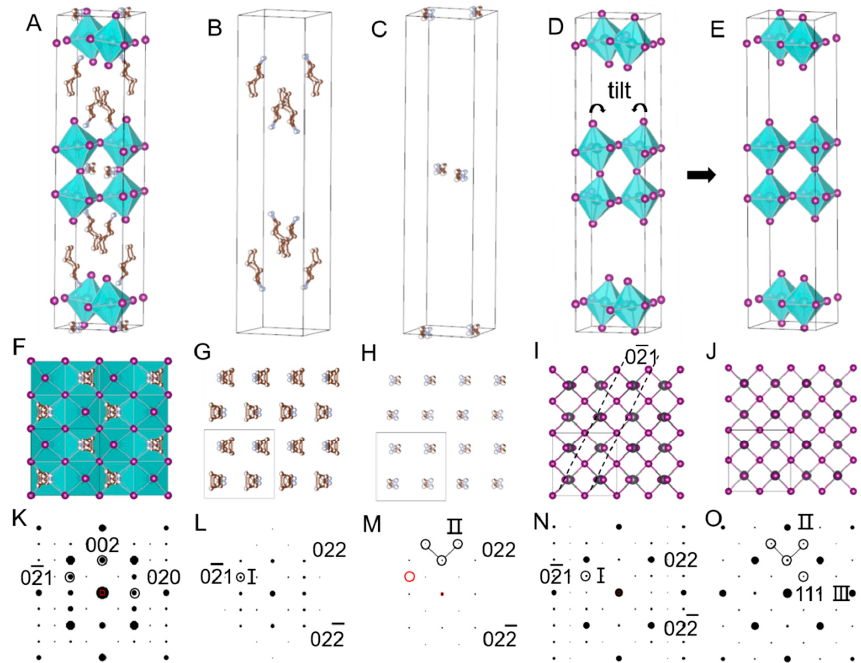
Figure 3. The structural model of BA 2 (MA / FA)Pb 2 I 7 ( A ), BA + ( B ), MA + / FA + ( C ), tilted [Pb 2 I 7 ] 3 − ( D ), and non-tilted [Pb 2 I 7 ] 3 − ( E ). ( F – J ) The corresponding structural projection along [100] direction in A – D . The (021) planes are depicted by dot lines. ( K – O ) Simulated SAED patterns of BA 2 (MA / FA)Pb 2 I 7 , BA + section, MA + / FA + section, tilted [Pb 2 I 7 ] 3 − section, and non-tilted [Pb 2 I 7 ] 3 − , respectively. The red circle indicates the missing (021 ) plane in the MA + / FA + section. I, II, and III denote the spot disappearance order under electron irradiation.